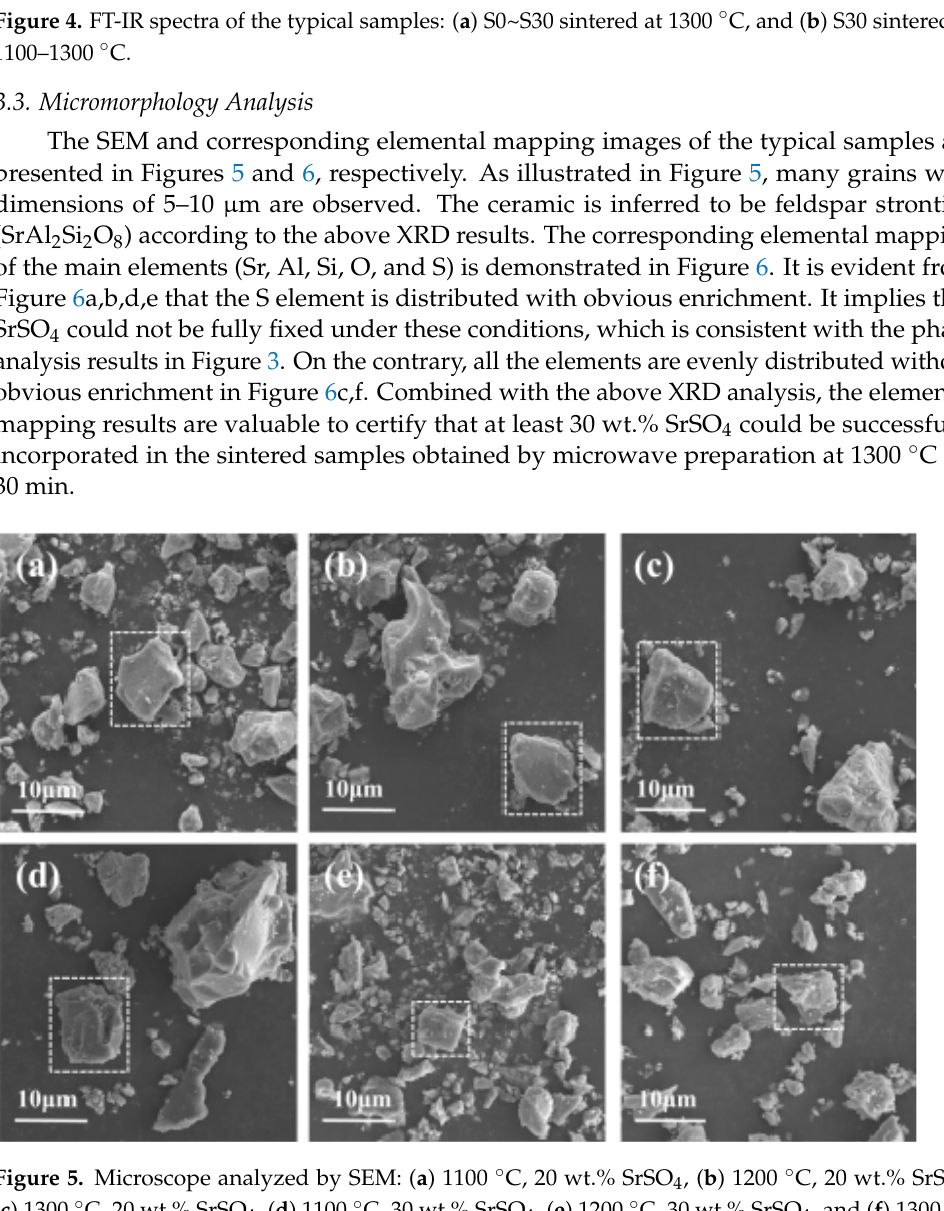
Figure 6. Elemental distribution of the sintered samples: ( a ) 1100 °C, 20 w t.% SrSO 4 , ( b ) 1200 °C, 20 w t.% SrSO 4 , ( c ) 1300 °C, 20 w t.% SrSO 4 , ( d ) 1100 °C, 30 w t.% SrSO 4 , ( e ) 1200 °C, 30 w t.% SrSO 4 , and ( f ) 1300 °C, 30 w t.% SrSO 4 .